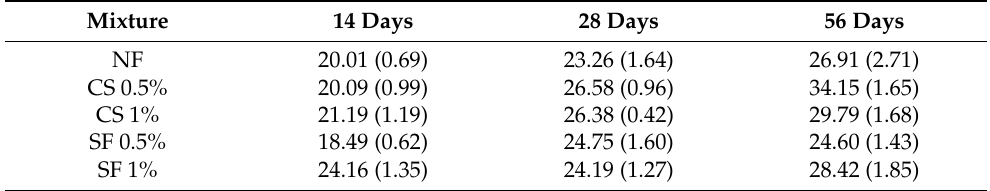
Table 6. Compressive strength results for base dosage of 20.59 MPa.